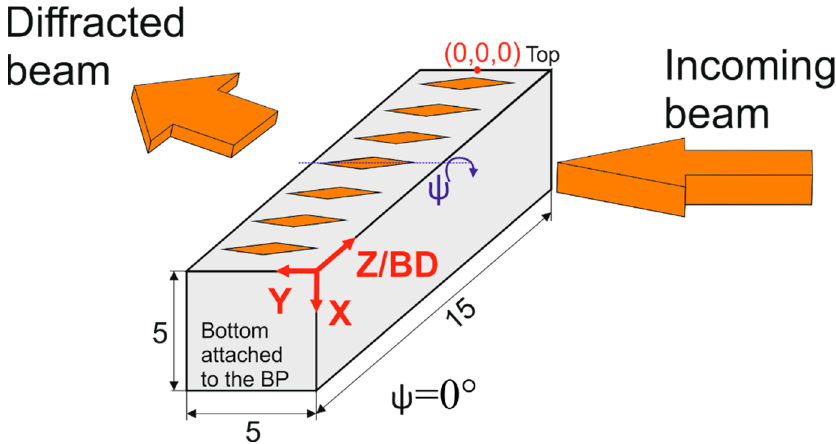
Figure 2. Schematic set-up of residual stress (RS) mapping and coordinate system of the sample. Note: gauge volume shape is simplified, a detailed description can be found in [9].